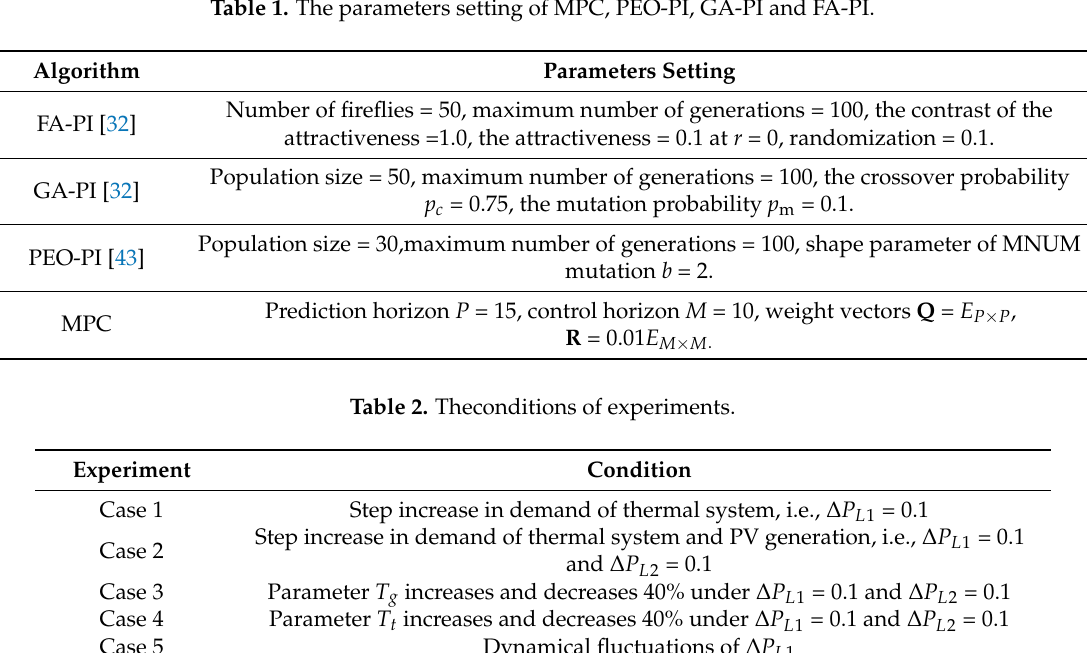
Table 1. The parameters setting of MPC, PEO-PI, GA-PI and FA-PI.